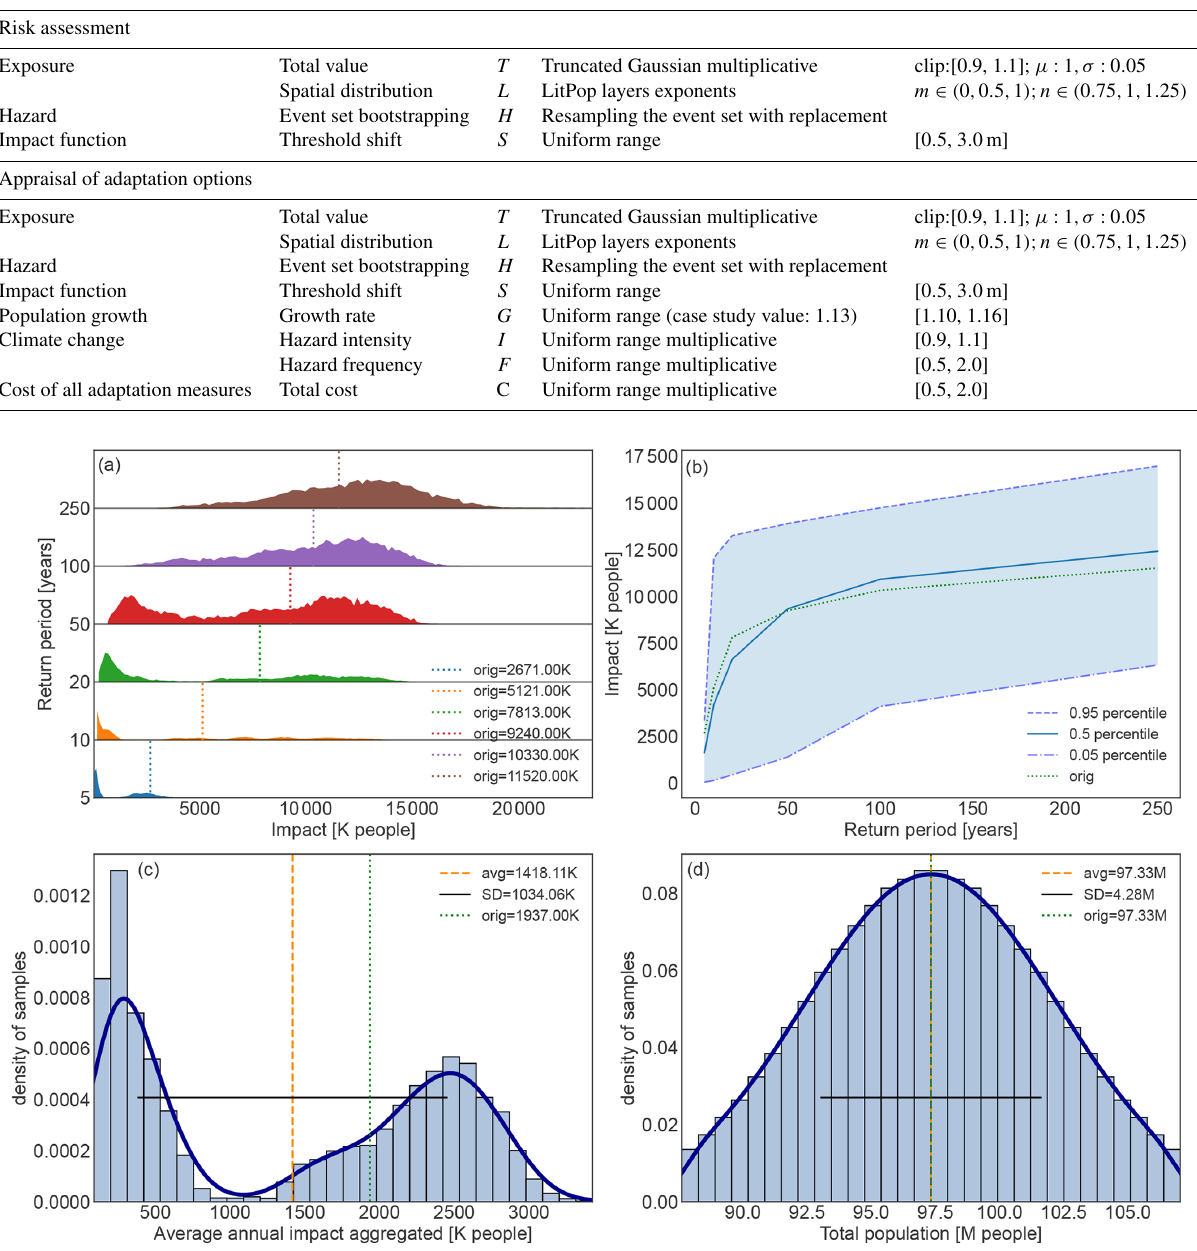
Table 1. Summary of the input parameter distributions. The input parameters T , L , and G characterize the uncertainty in the exposure (people), H , I , and F in the hazard (storm surge), S in the impact function (vulnerability), and C in the adaptation measures (mangroves, sea dykes, gabions). The parameters T , L , H , and S are needed for risk assessment (cf. Sect. 3.2.1), and the parameters T , L , H , S , G , I , F , and C are needed for adaptation options appraisal (cf. Sect. 3.3.1).